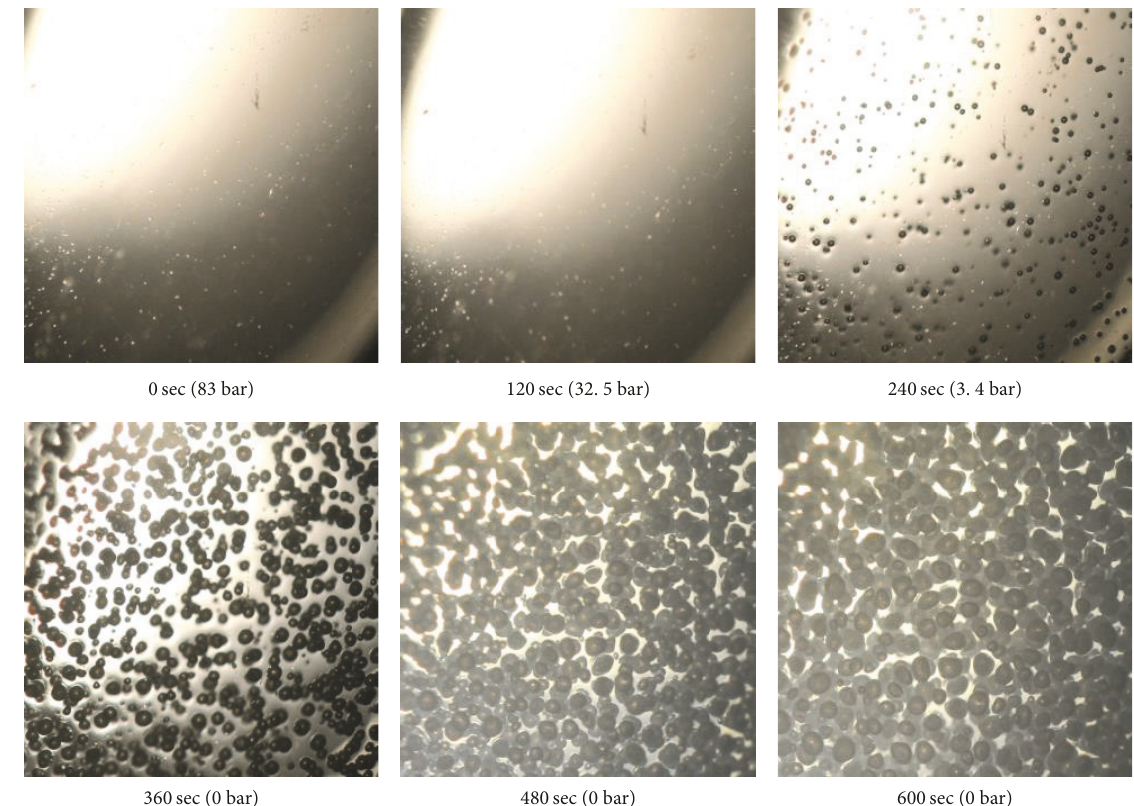
Figure 9: Photographs of a 1mm thick PS sample at various times after the onset of depressurization after holding at 83bar (in CO 2 ) and 70 ∘ C for 2 hours (scale of images is 6 ×